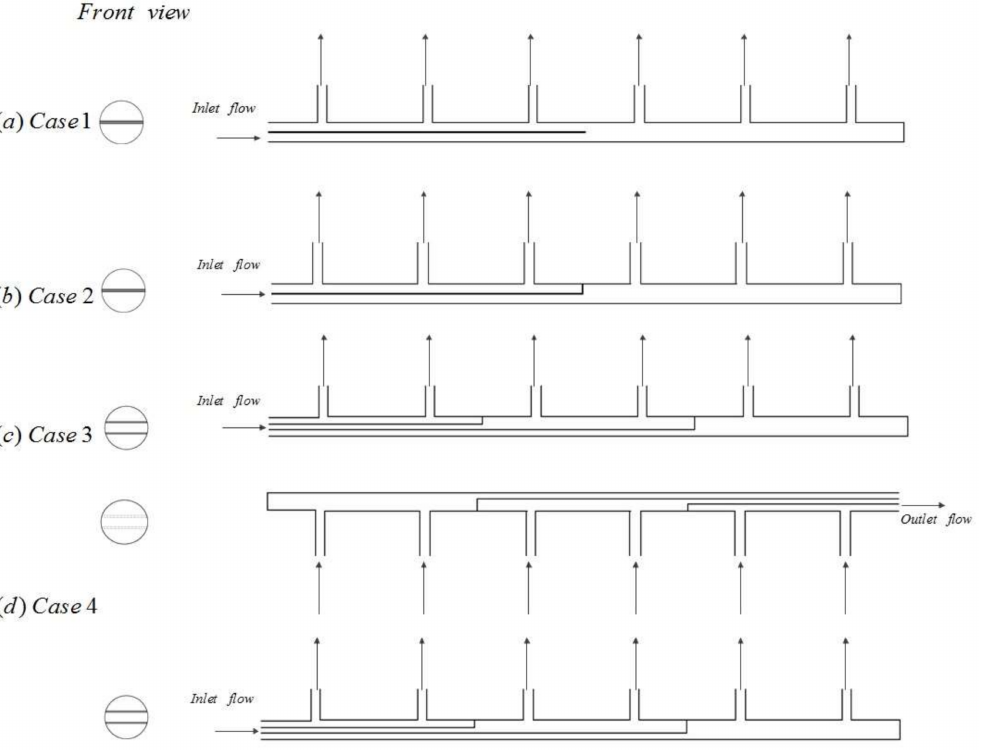
Figure 4. Study cases analyzed in the present